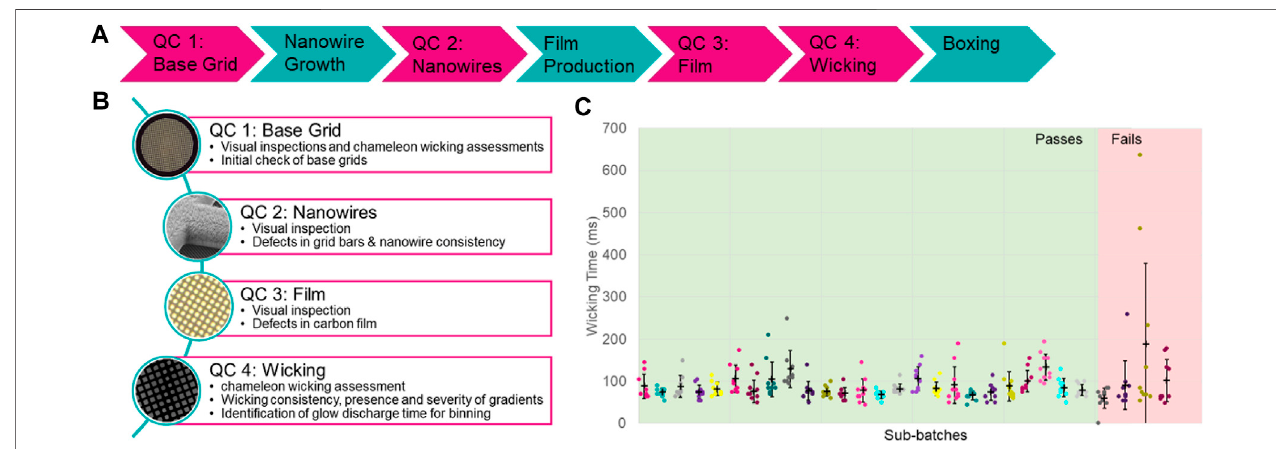
FIGURE 4 | The self-wicking grid manufacturing and quality assessment process. (A) A schematic overview of the steps taken to both manufacture (teal) and assess the quality (magenta) of self-wicking grids. (B) Descriptions of the quality control checks that are in place. (C) Example wicking QC data, indicating sub-batches that have passed or failed. Sub-batches are tested using a standard sample and range of glow discharge times.